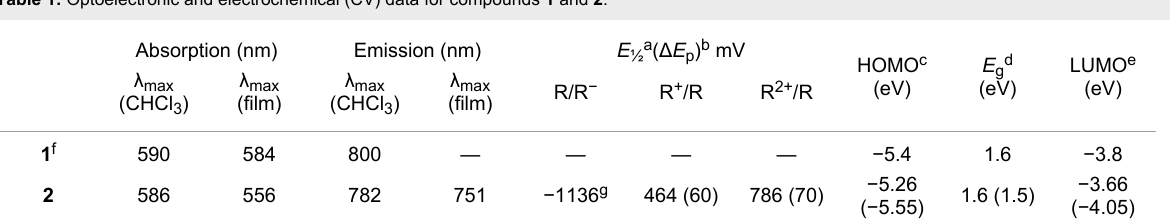
Table 1: Optoelectronic and electrochemical (CV) data for compounds 1 and 2